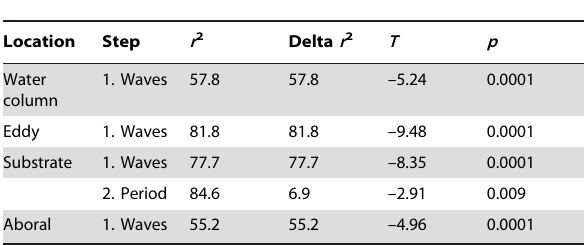
Table 1. Stepwise regression analyses.